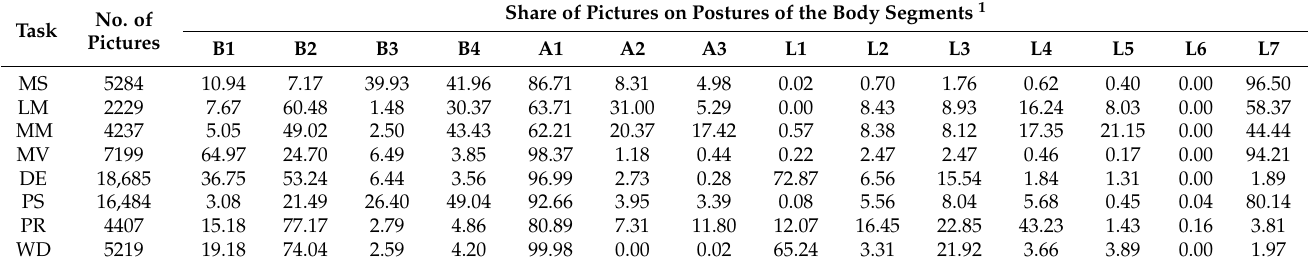
Table 3. Share of body postures on tasks.